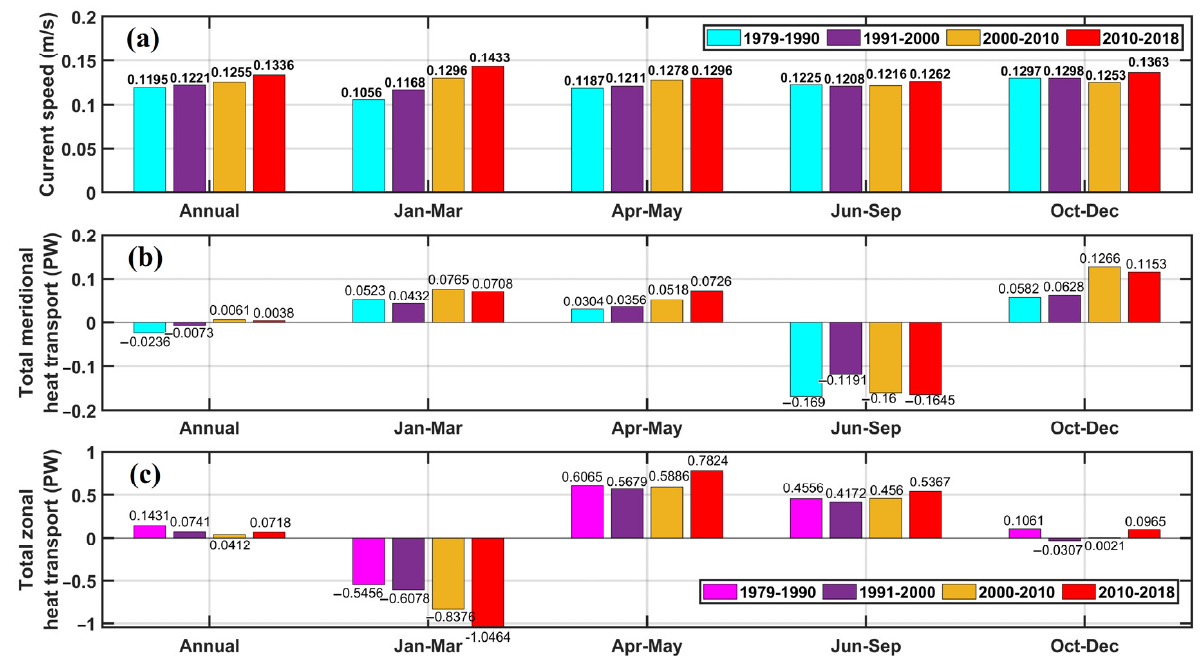
Figure 9. Decadal variation in ( a ) current speed, ( b ) meridional heat transport, and ( c ) zonal heat transport for different seasons in domain D1.